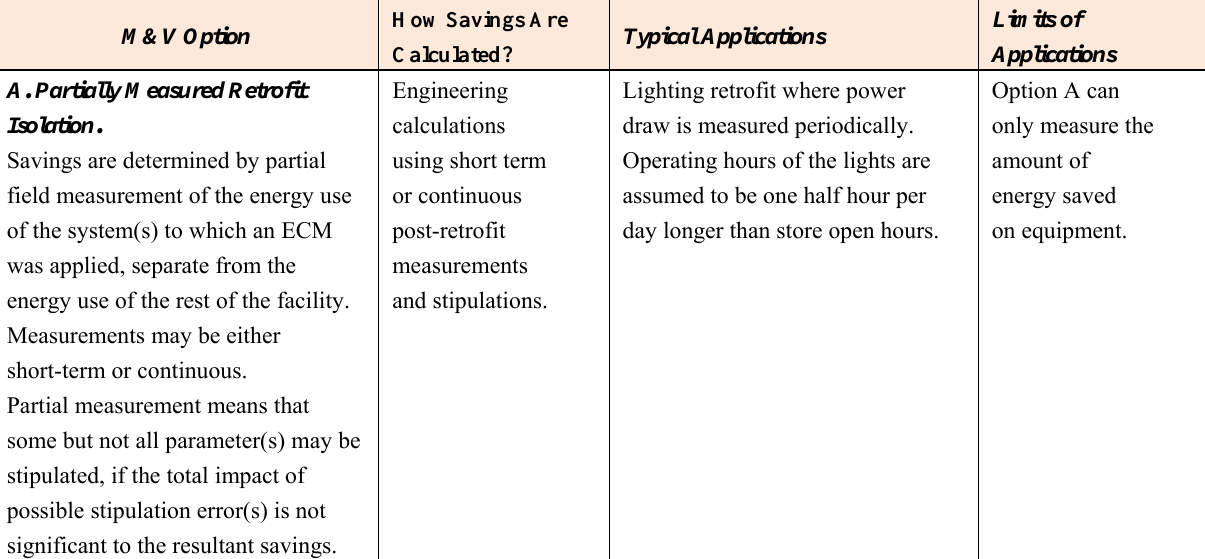
Table 3. Comparison of IPMVP options and improved version of option